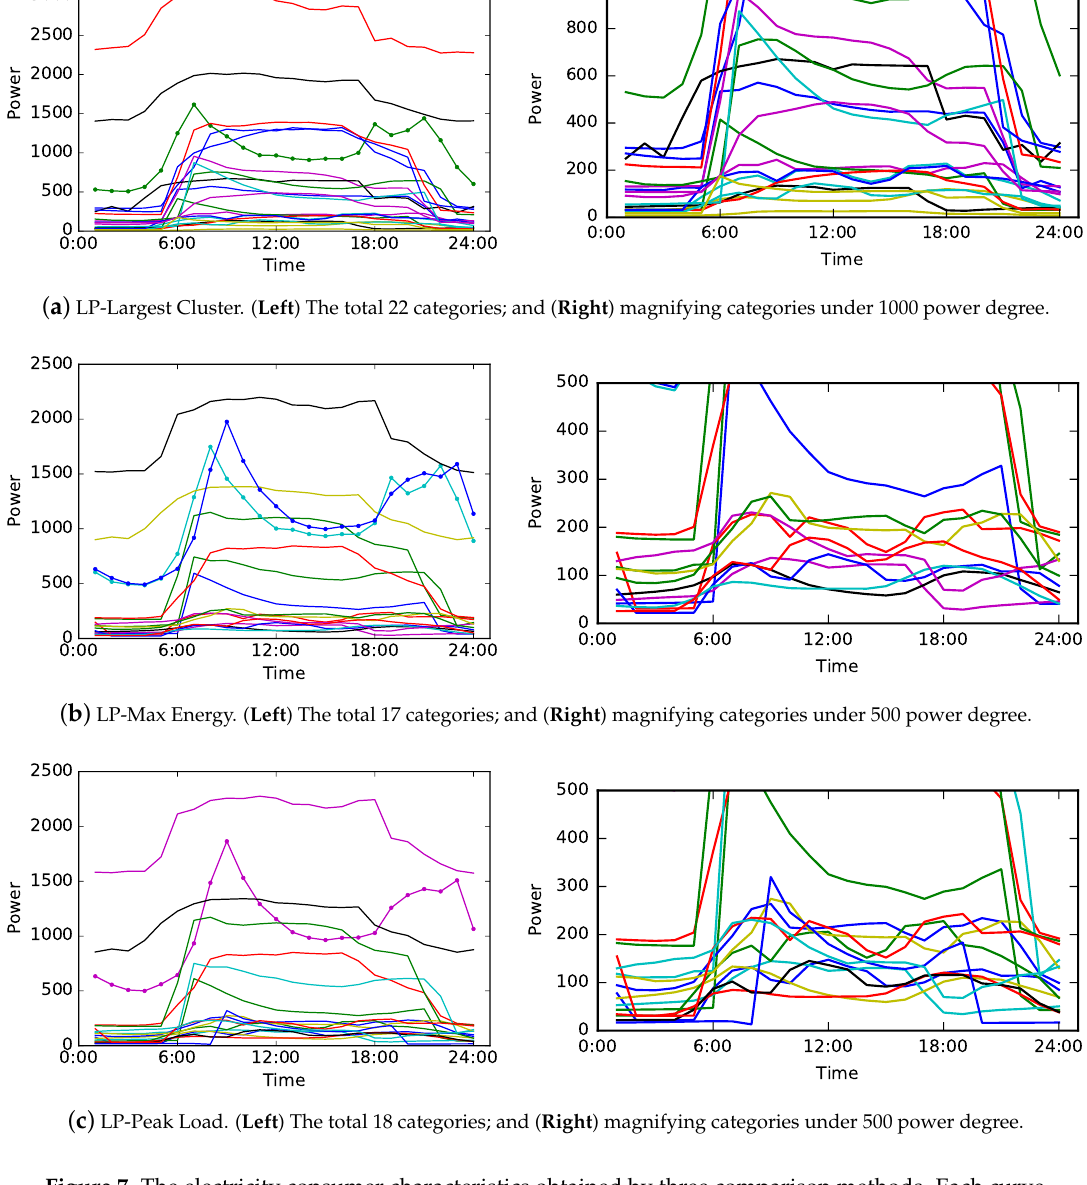
Figure 7. The electricity consumer characteristics obtained by three comparison methods. Each curve in every subfigure denotes the characteristic of one consumer category. These results are obtained based on the same training data as Figures 4–6. ( a – c ) ( Left ) show the characteristics of total consumer categories of methods, and ( a – c ) ( Right ) magnify the characteristics of partial categories shown in the left